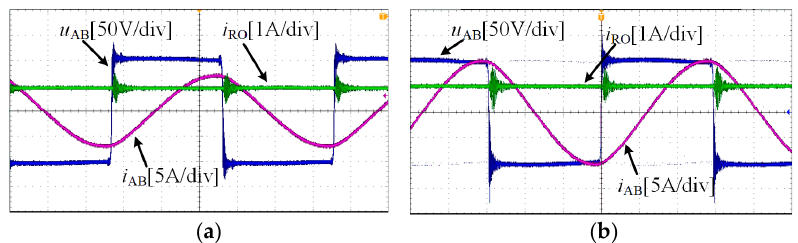
Figure 12. Waveforms of the CCO-type LCC-S compensation topology in Case A: ( a ) R O = 100 Ω , k = 0.5; ( b ) R O = 100 Ω , k = 0.25.